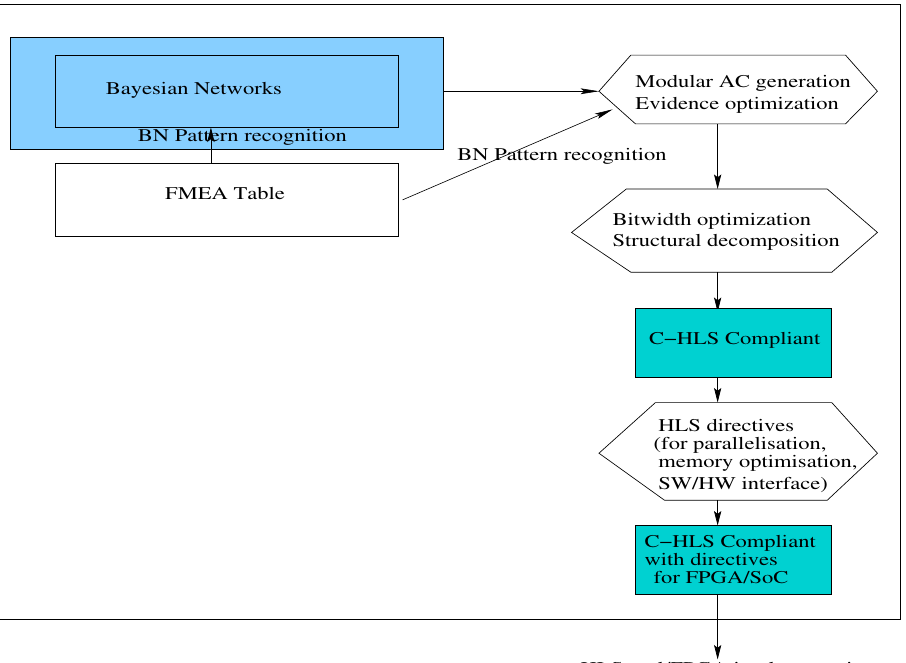
Figure 11. Our design tool proposal for the FPGA implementation of BN monitors from FMEA-like tables (F2F